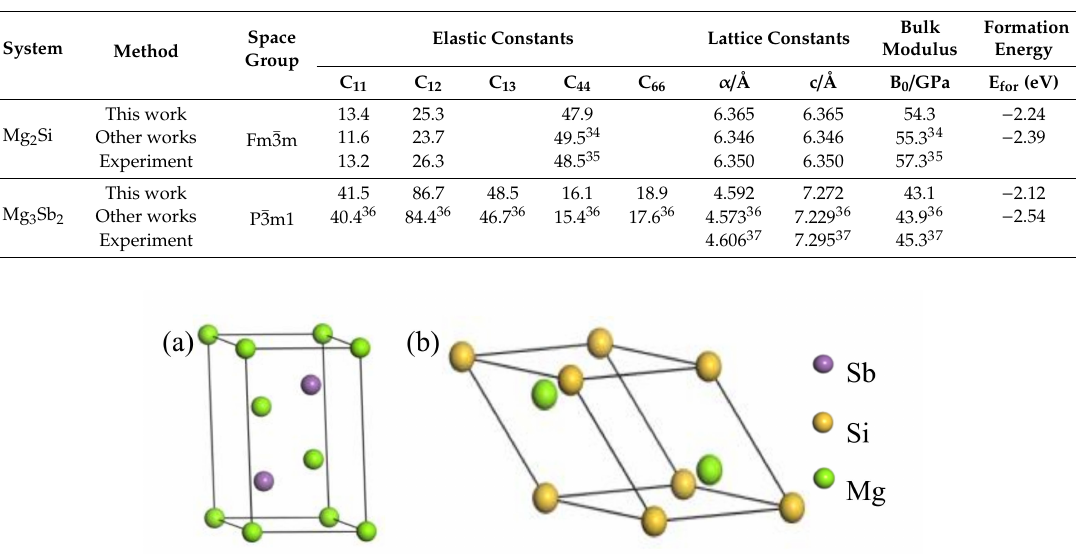
Figure 1. The crystal structure of ( a ) Mg 3 Sb 2 and ( b ) Mg 2 Si.